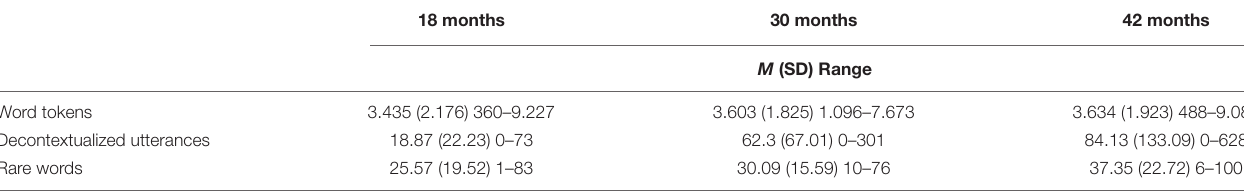
TABLE 2 | Descriptive statistics for parental input measures including mean ( M ), standard deviation (SD), and min–max range ( n = 23).